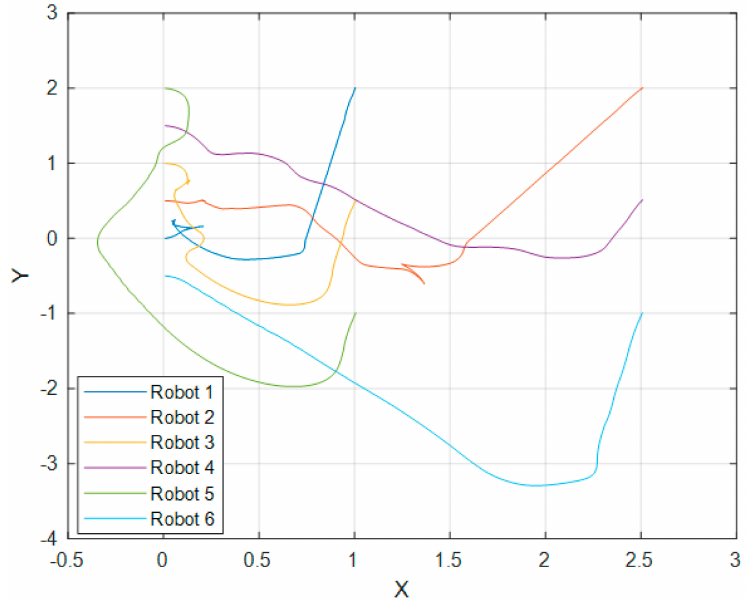
Figure 10. Trajectories in the 6-robot simulation.